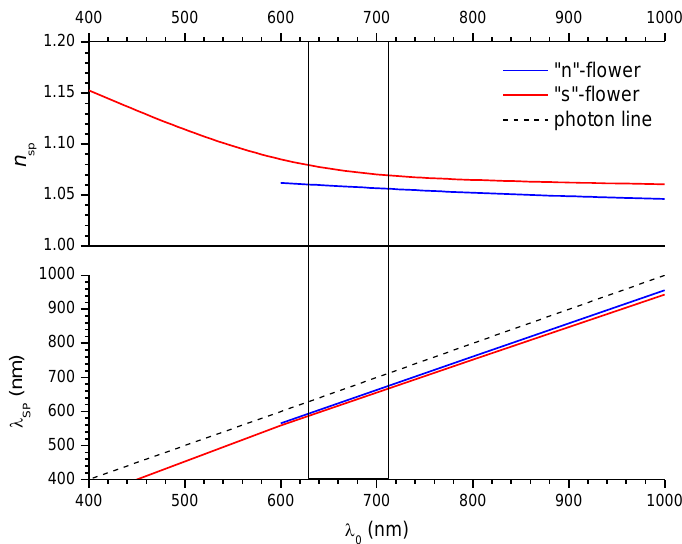
Figure A2. Lower panel: Dependence of the SP wavelength λ SP (lower panel) and the effective SP refraction index n SP on the free-space wavelength λ 0 . Only values λ 0 > Λ are presented. The Raman spectrum window is marked with vertical lines. The as-obtained resonator modes were tailored with the plane-wave expansion of the field in the z < 0 region (i.e., in air) and in a thick silver base at the bottom ( z > h ).